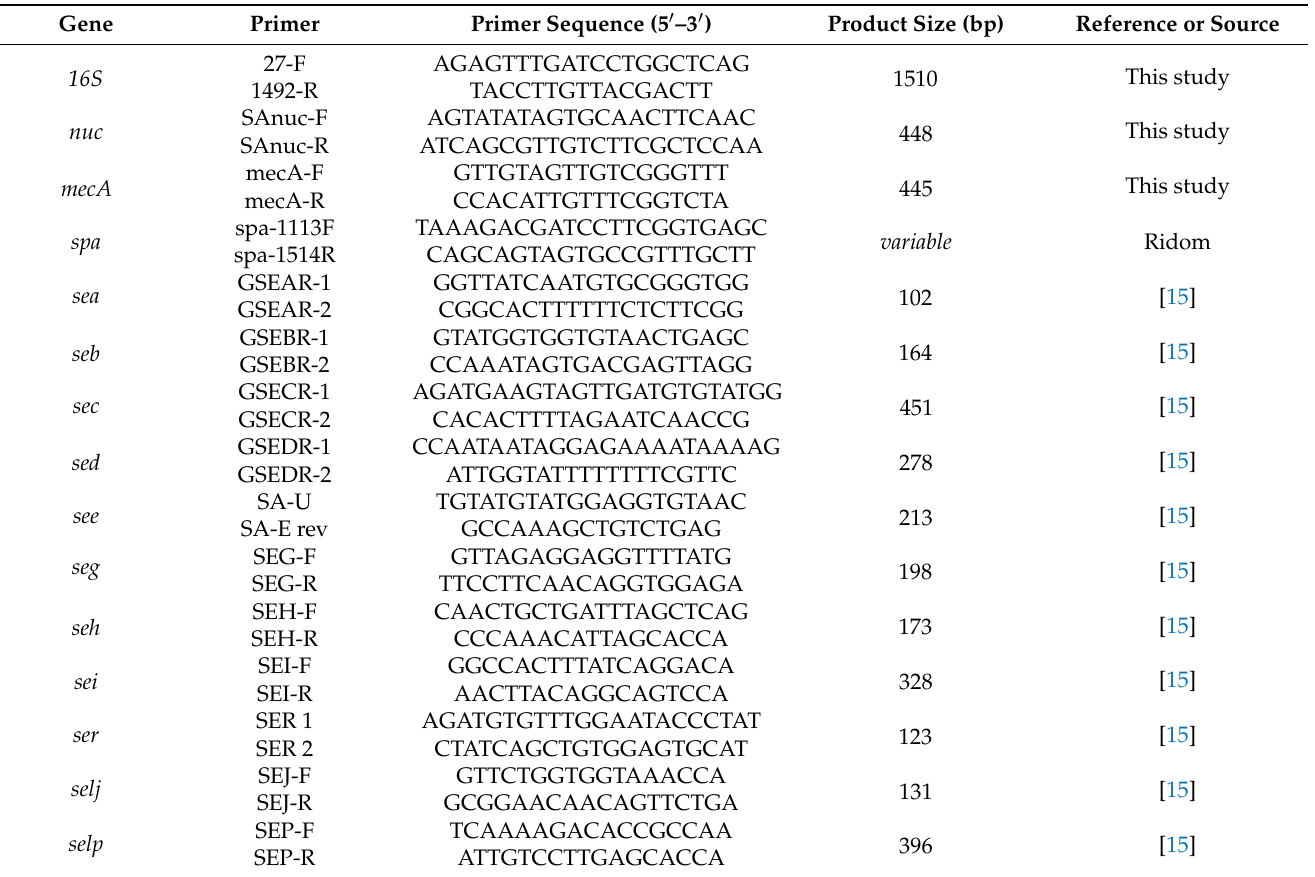
Table 1. Oligonucleotide primers used in this